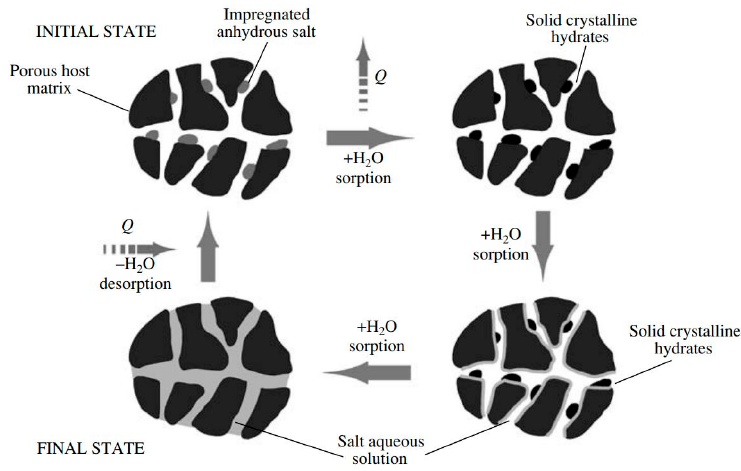
Figure 7. The working principle of a composite adsorbent [13], with permission from Springer Nature, 2007.